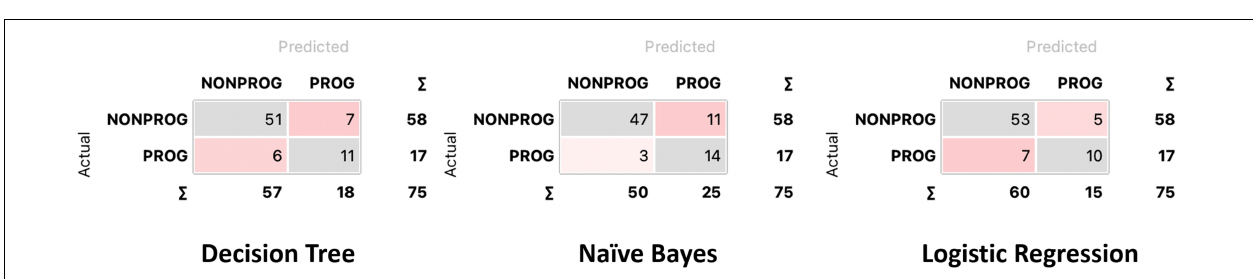
FIGURE 3 | Confusion matrix for decision tree, Naïve Bayes, and logistic